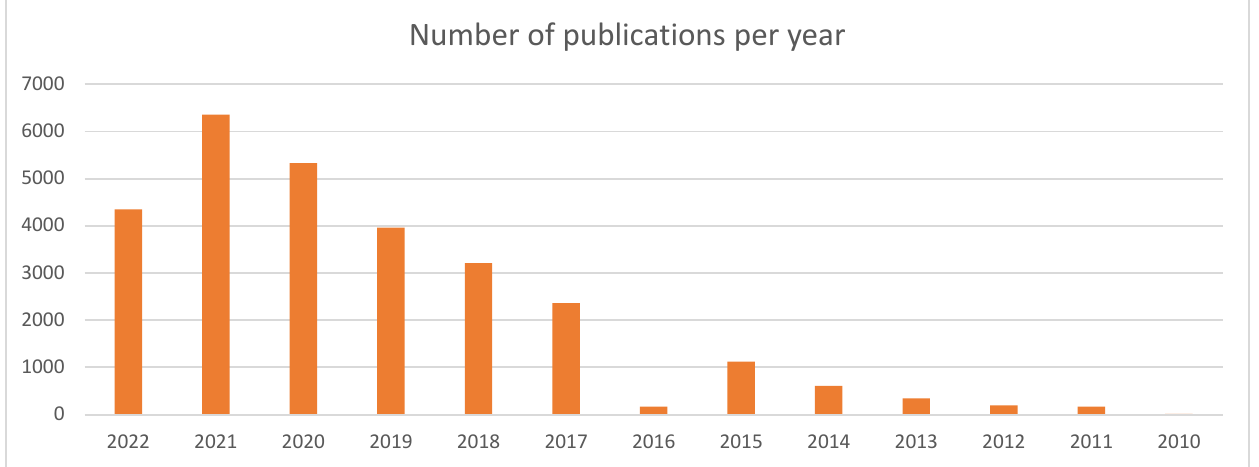
Figure 1. Search of Pubmed for articles related to medical 3D printing in recent years. Search query: “Three-dimensional printing” OR “3D-Printed” OR “3d-print” OR “Threeprint” OR “3D print” OR “rapid prototyping” OR “additive manufacturing”.